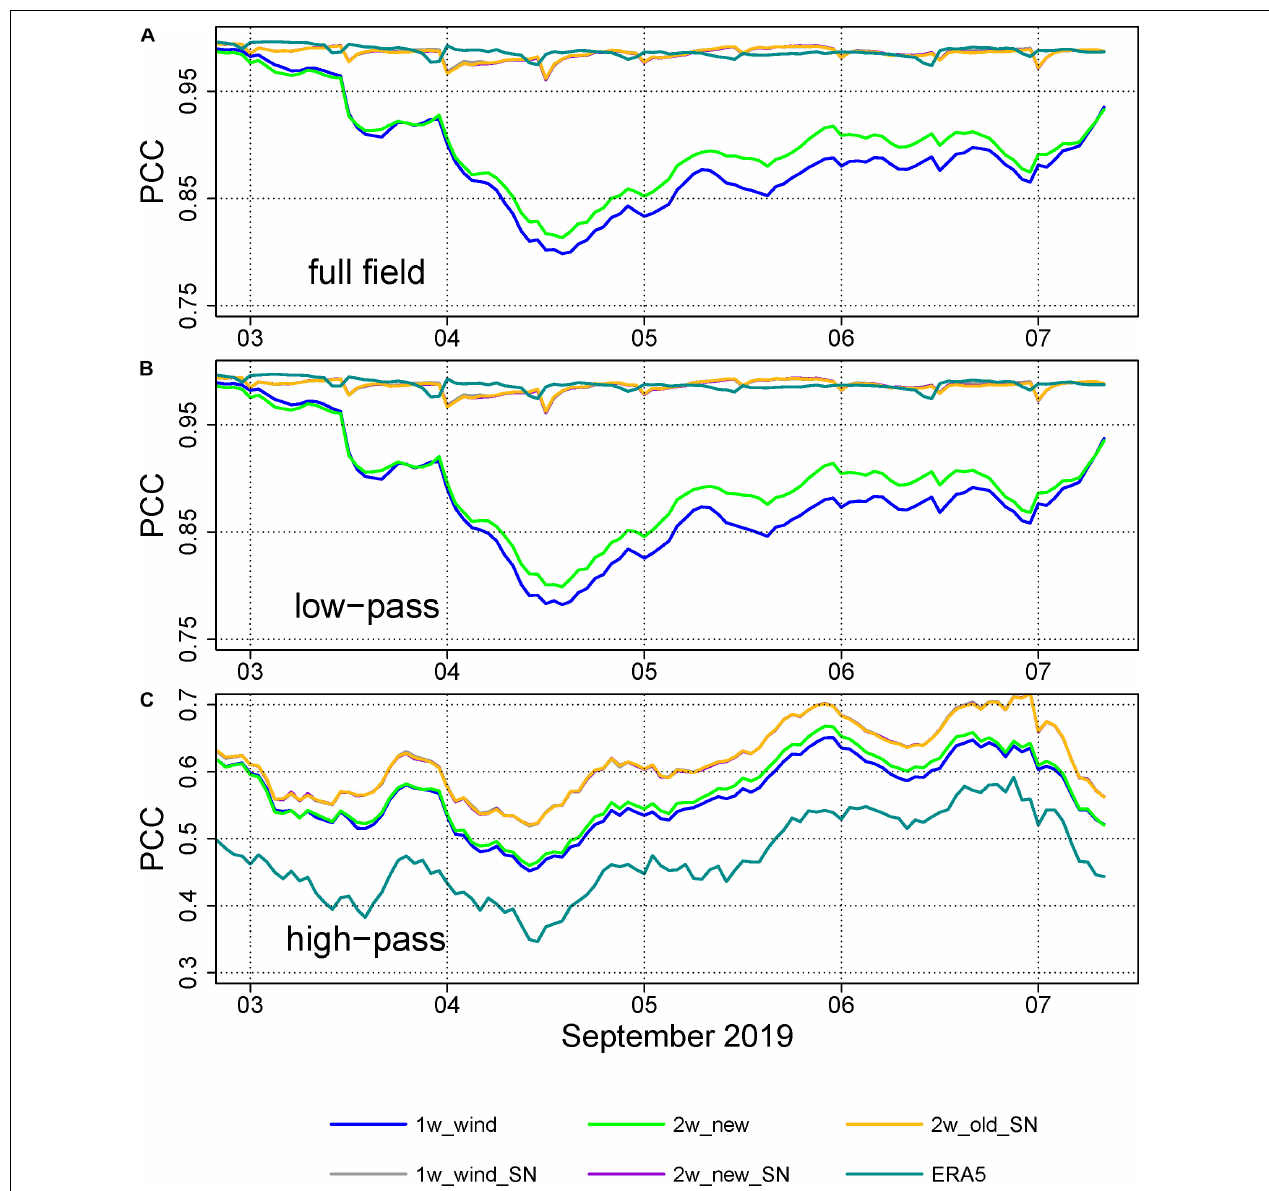
FIGURE 12 | Time series of pattern correlation coefficient (PCC) of the sea level pressure between the ECMWF and simulations and ERA5 during Typhoon Lingling period for (A) full fields, (B) low-pass-filtered fields, and (C) high-pass-filtered